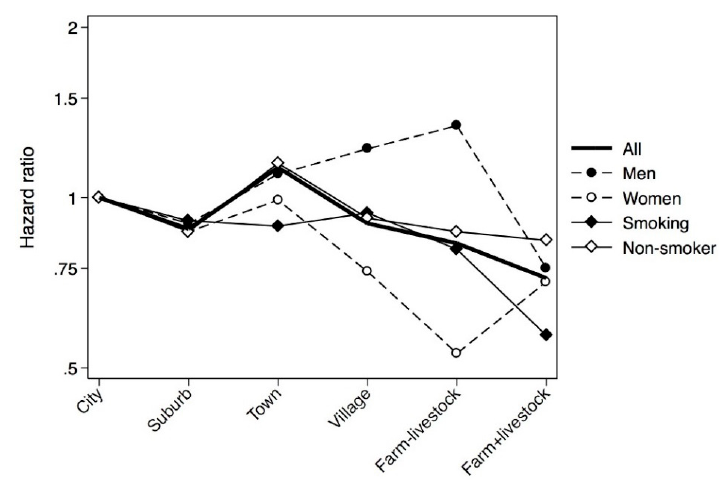
Figure 1. Cox regression subgroup analyses on asthma presented as HR adjusted for age, sex, centre, parental asthma, smoking, body silhouette at 8 years of age and parental smoking in childhood.